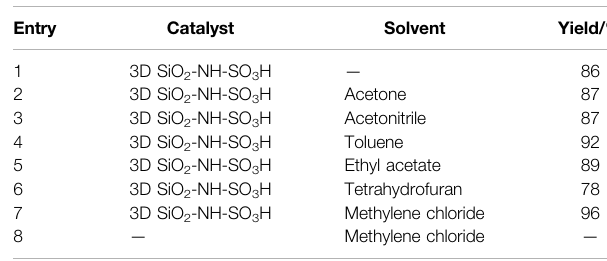
TABLE 1 | Comparison of the best solvents for reaction in the presence of 3D SiO 2 -NH-SO 3 H.